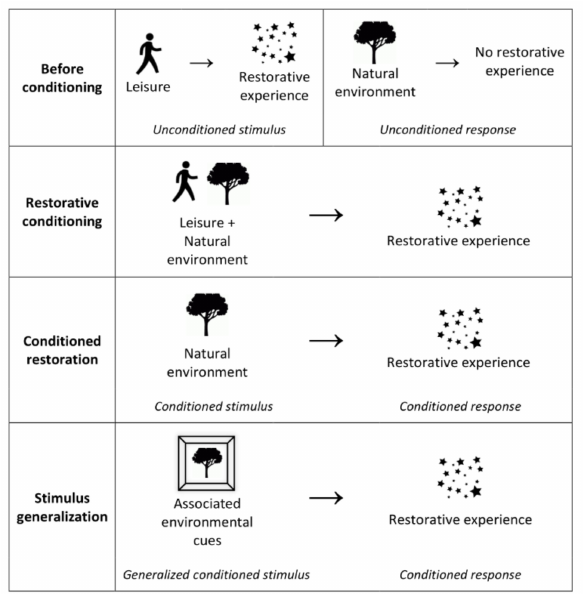
A schematic model of conditioned restorative theory (CRT) in a leisure–nature– restoration